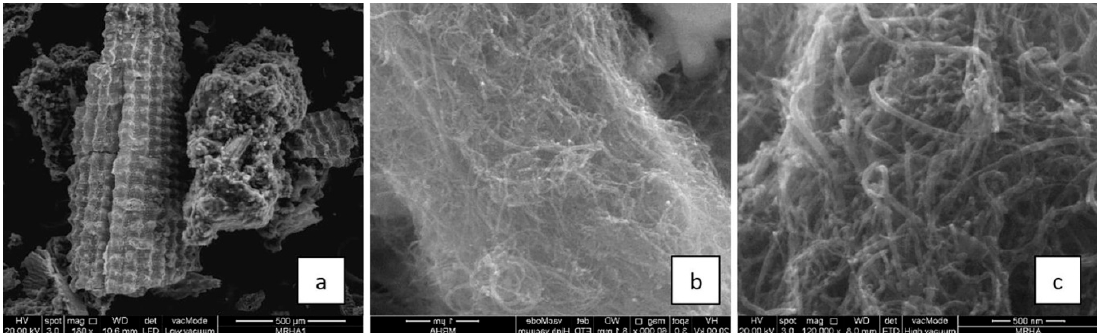
Figure 3. Surface and cross-sectional morphology of rice husk ash biopolymer before coating with CNFs, ( a–c ) for different scales [47] (Reproduced with permission from publisher).